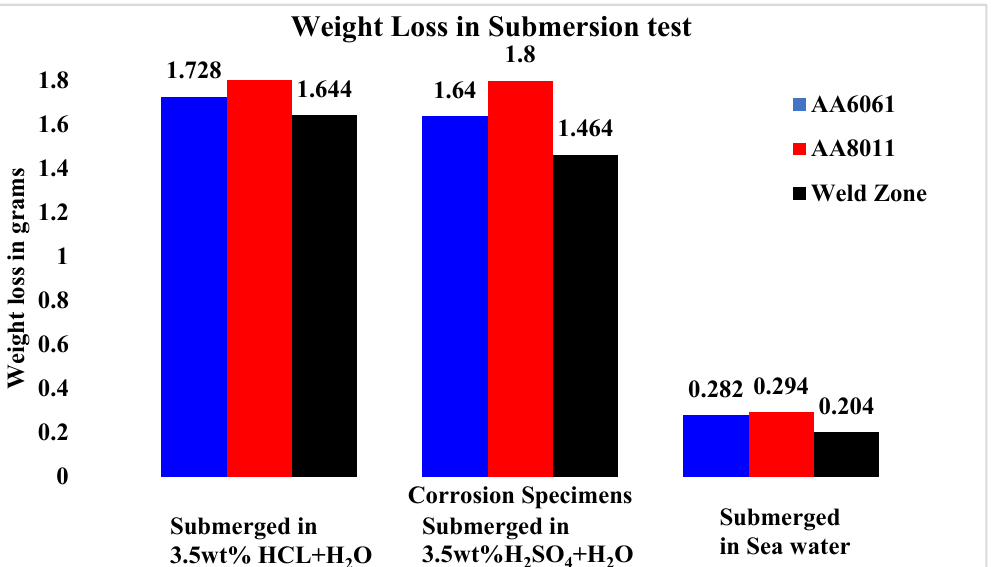
Figure 7. Weight loss values for base material and weld region specimens after 28 days of submersion in three different solutions.